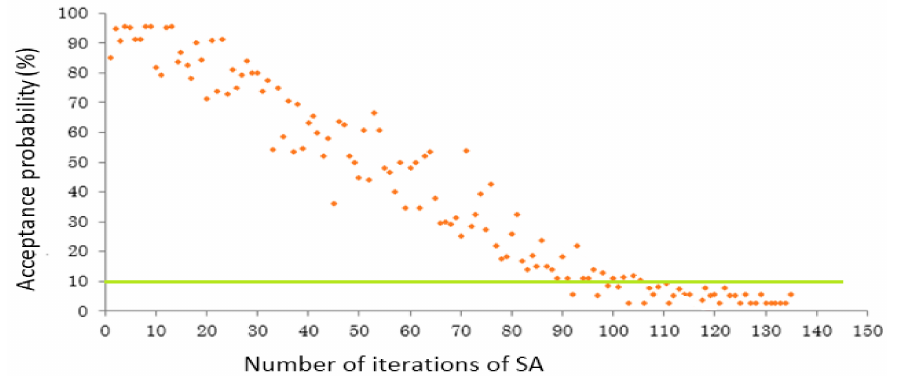
Figure 4. Sensibility analysis for SA